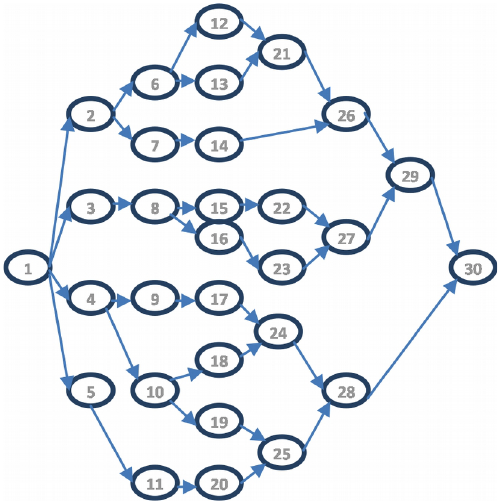
Figure 22. Network diagram for experiment number 2